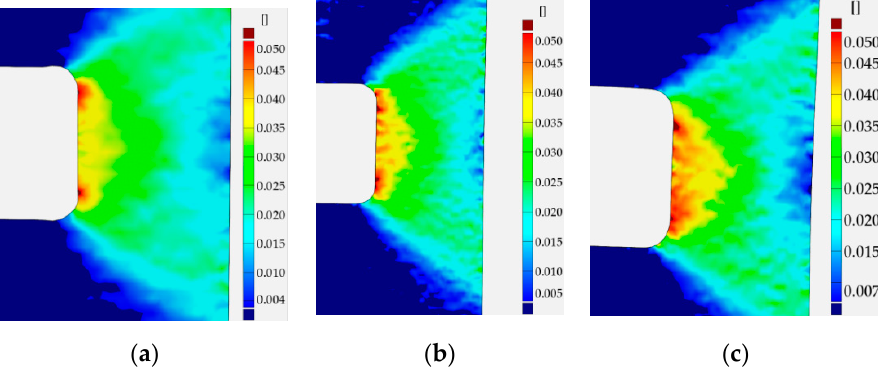
Figure 28. Distribution of strain field (DIC) in samples with square holes made of 41Cr4 steels: ( a ) 41Cr4 + AC, Sample 11; ( b ) 41Cr4 + AC, Sample 12; and ( c ) 41Cr4 + QT, Sample 14.